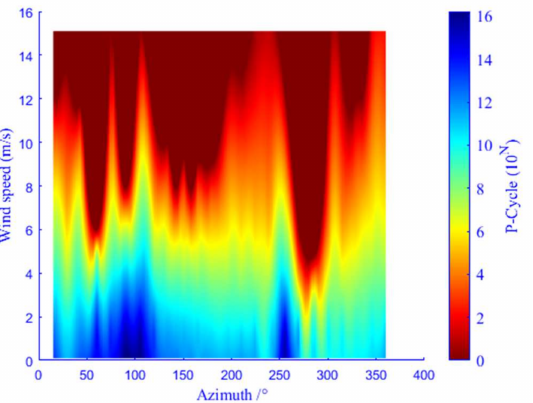
Figure 10. Node-azimuth-wind velocity-probability life in northwest region.